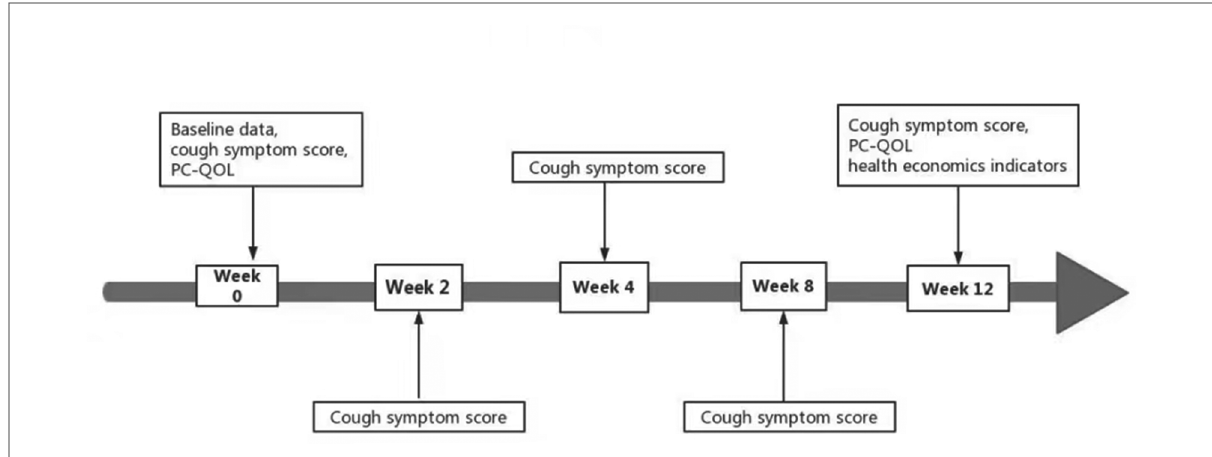
FIGURE 1 Outcome indicators during